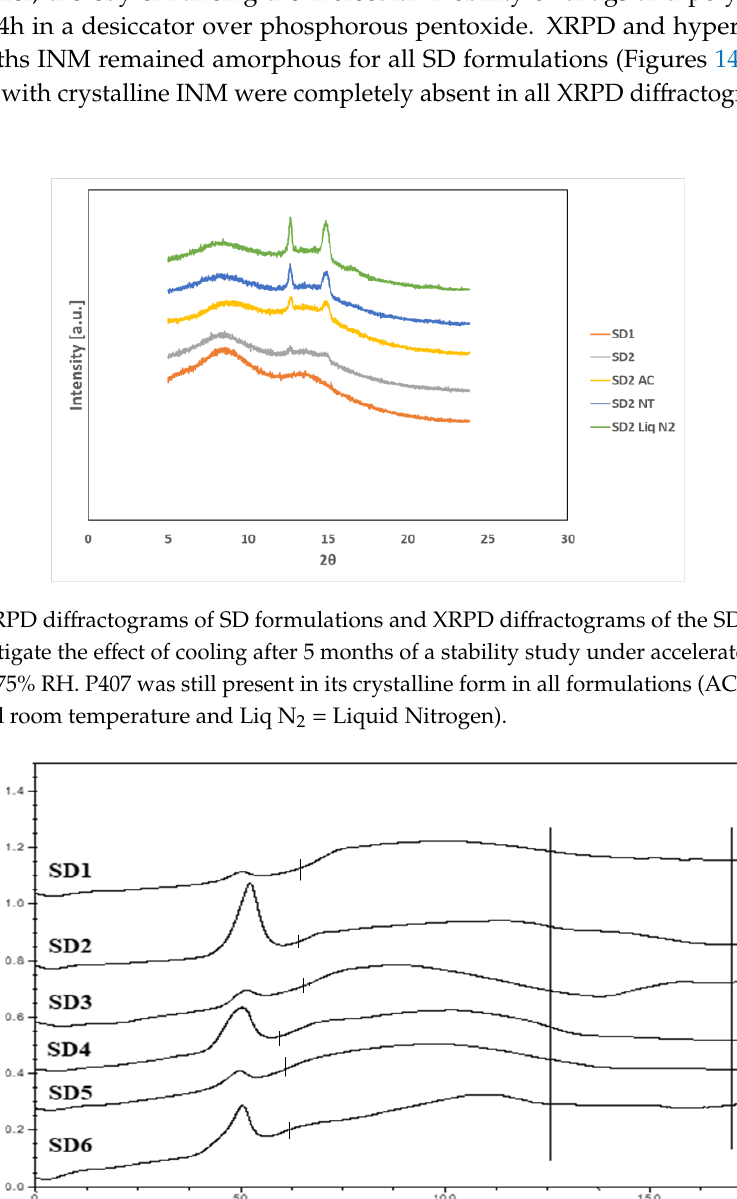
Figure 15. Hyper DSC thermograms of air-cooled SD formulations after 5 months of a stability study under accelerated conditions of 40 °C and 75% RH. P407 was still present in its crystalline form in all formulations. The area of interest for crystalline INM melting endotherm is marked by straight lines. T g is indicated by a tick.